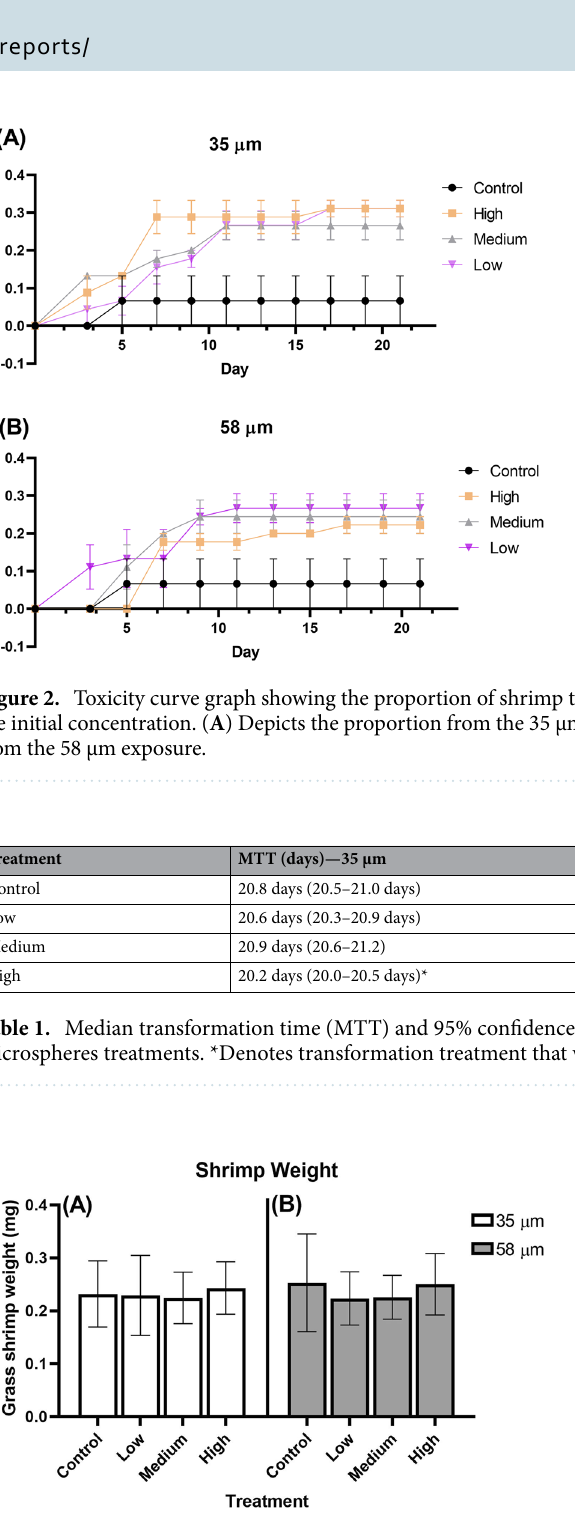
Figure 3. Mean weights of shrimp from size treatments. ( A ) the 35 µm exposure and ( B ) the 58 µm exposure along with control weights. We observed no difference in shrimp weights among the three treatments and the control for both particle